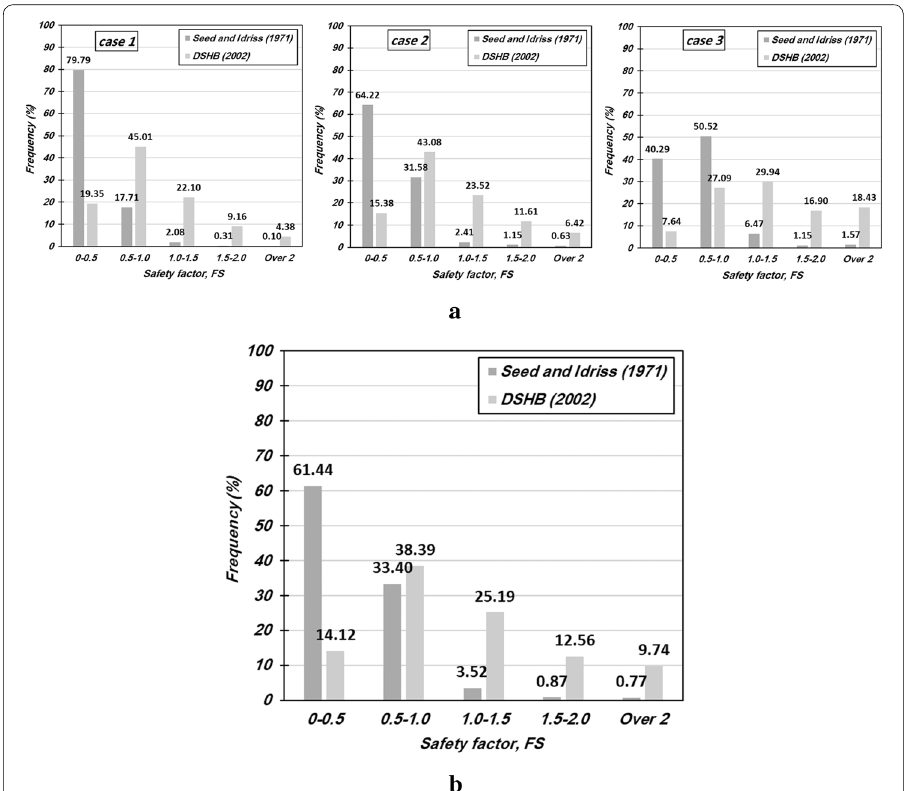
Fig. 8 Histogram of calculated safety factors against liquefaction through Seed and Idriss [1] and DSHB [8] method for: a cases 1, 2 and 3; and b three